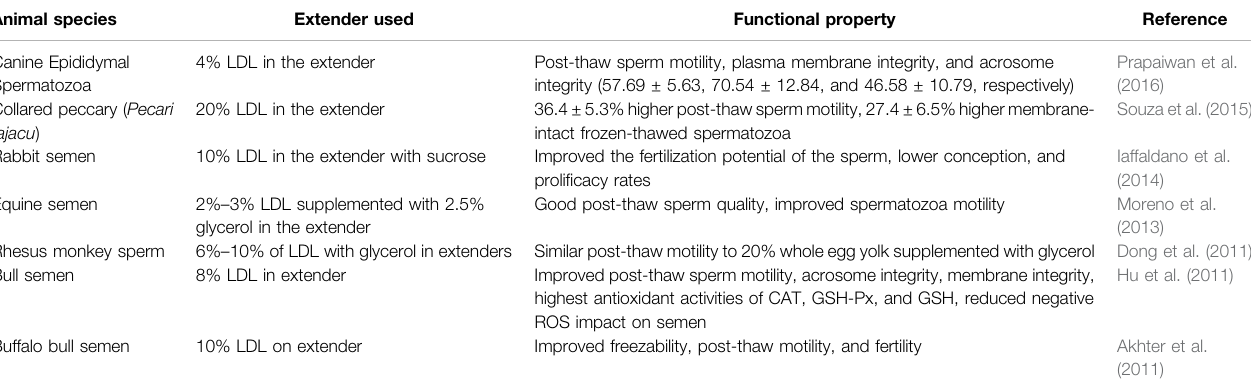
TABLE 2 | Use of Egg yolk LDL in cryopreservation of animal spermatozoa. Animal species Extender